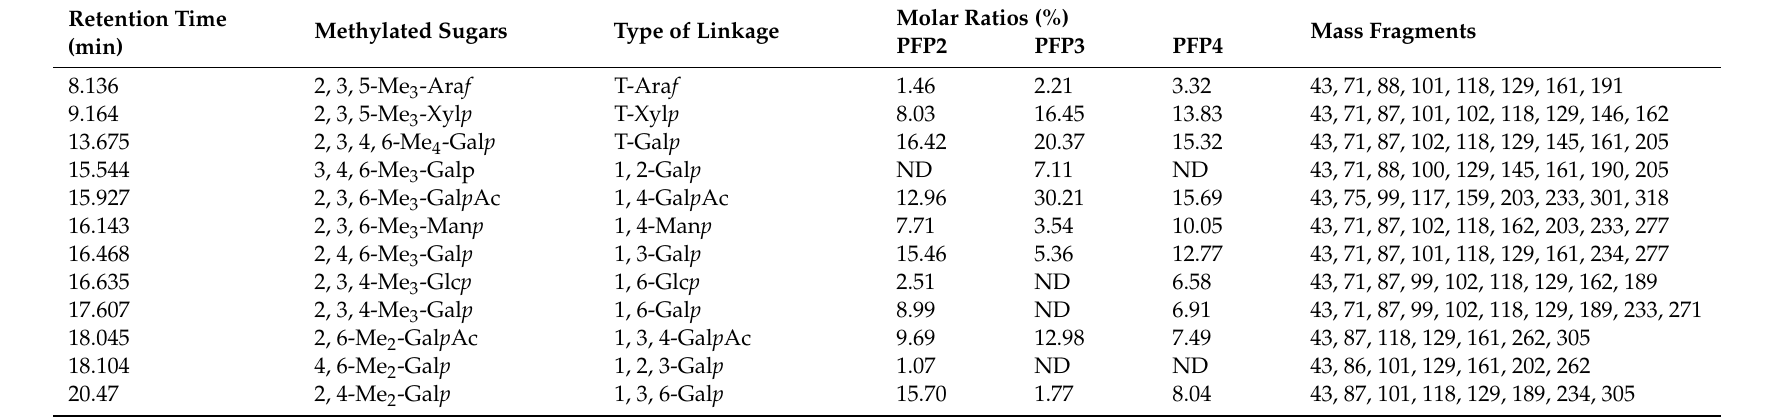
Table 2. Methylate analysis data of PFP2, PFP3, and